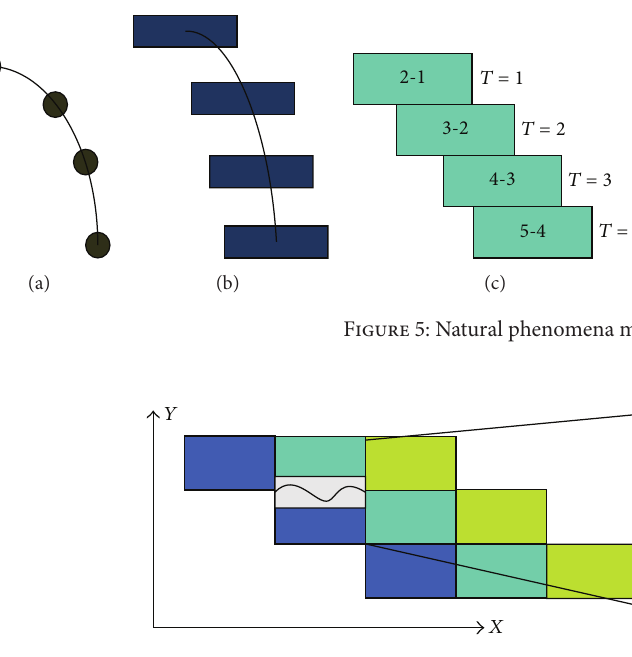
Figure 6: Overlap regions between patches.